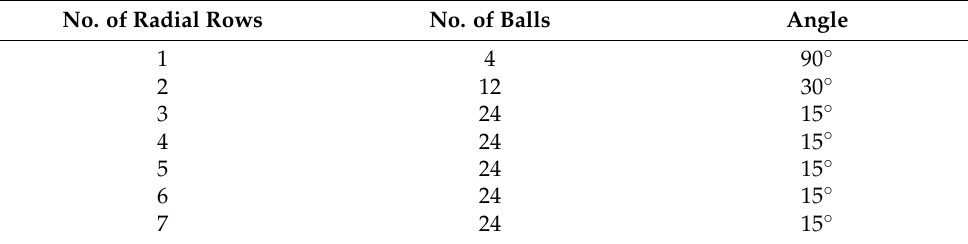
Table 2. The geometry of balls. N = 2040 balls. No. of Radial Rows No. of